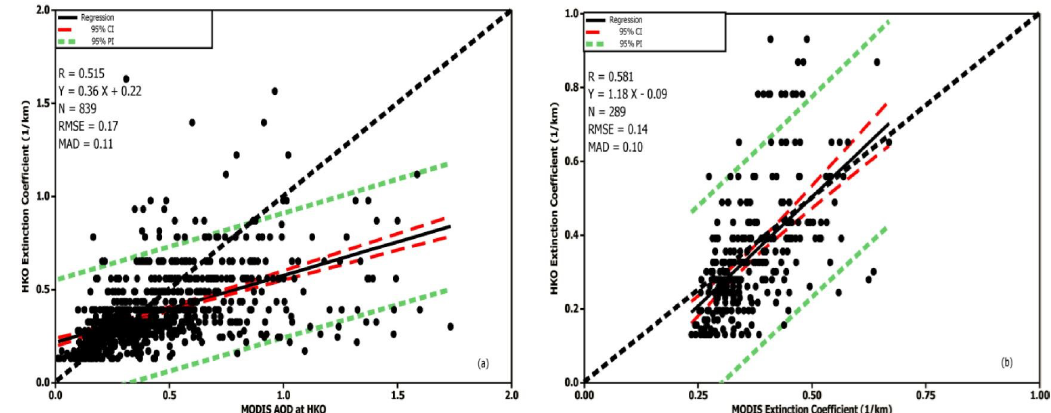
Figure 10. Correlation of Extinction Coefficient with MODIS AOD (10 km product at 550 nm) using Model-1 for HKO: ( a ) linear regression of training data for the years 2002 to 2006 and 2008; ( b ) estimated MODIS extinction coefficient using MODIS AOD from years 2007 and 2009. Black dashed line represents a 1:1 line, whereas black solid line is the resultant regression